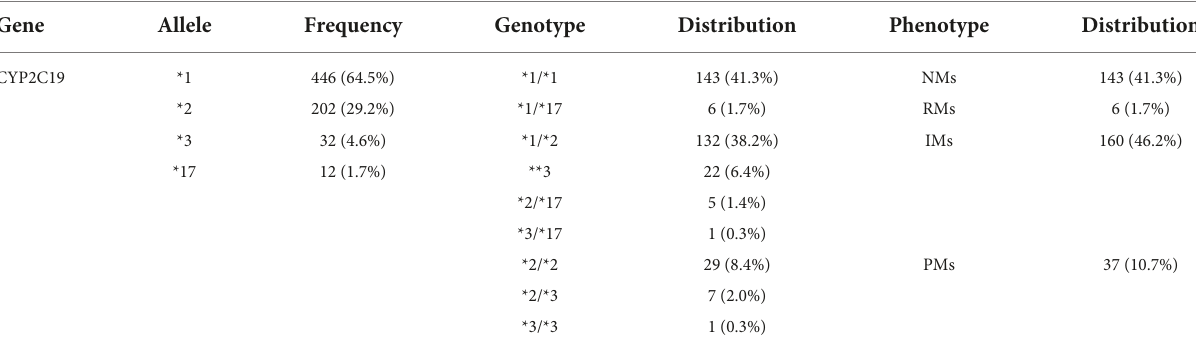
TABLE 1 Distribution of CYP2C19 gene polymorphisms in children with KD.